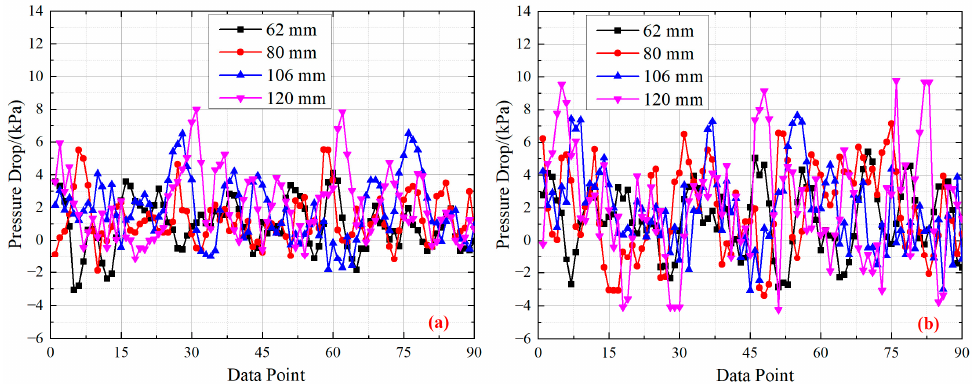
Figure 5. Different stages of flow instability at various amplitude ( J w = 1.1 m/s): ( a ) J g = 1.0 m/s, H = 0.5 Hz, ( b ) J g = 1.0 m/s, H = 0.8 Hz.